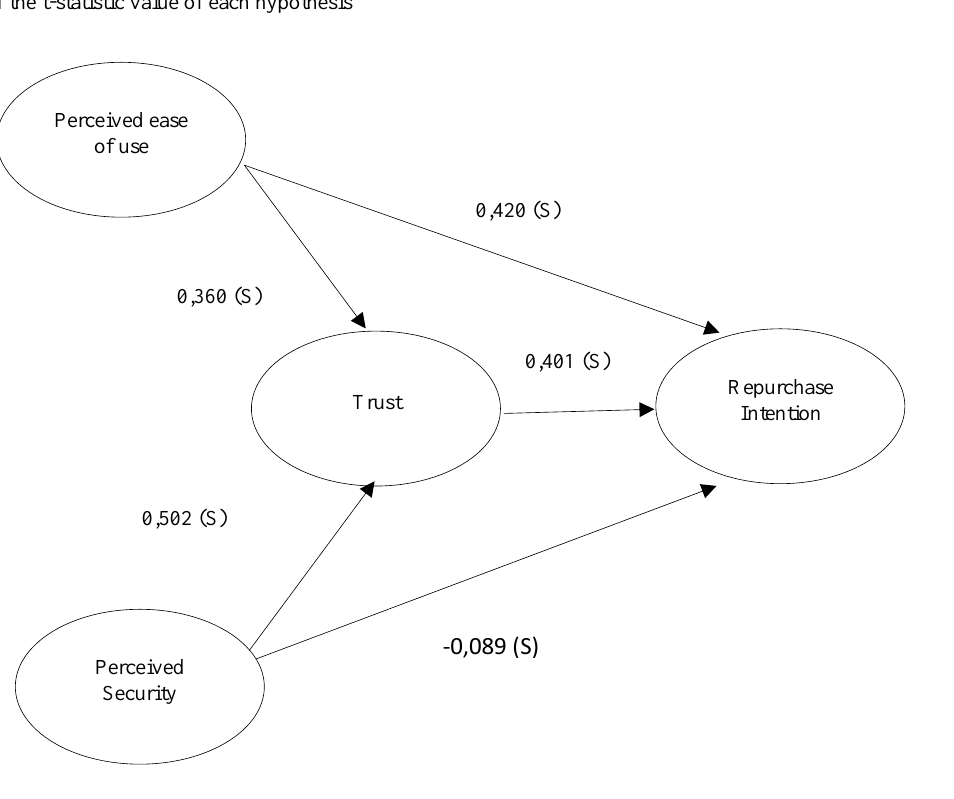
Figure 2: Direct Effect Test Results; Source: Processed Primary Data